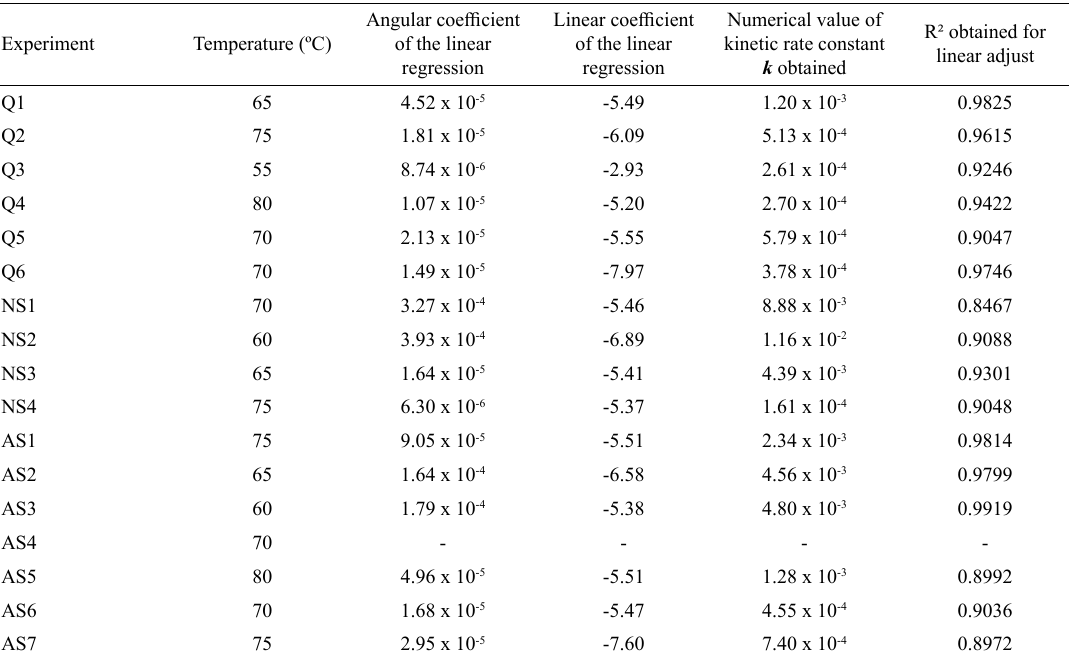
Table 7. Angular and linear coefficients of Equation 18 and numerical values of the rate constants obtained for each experiment.